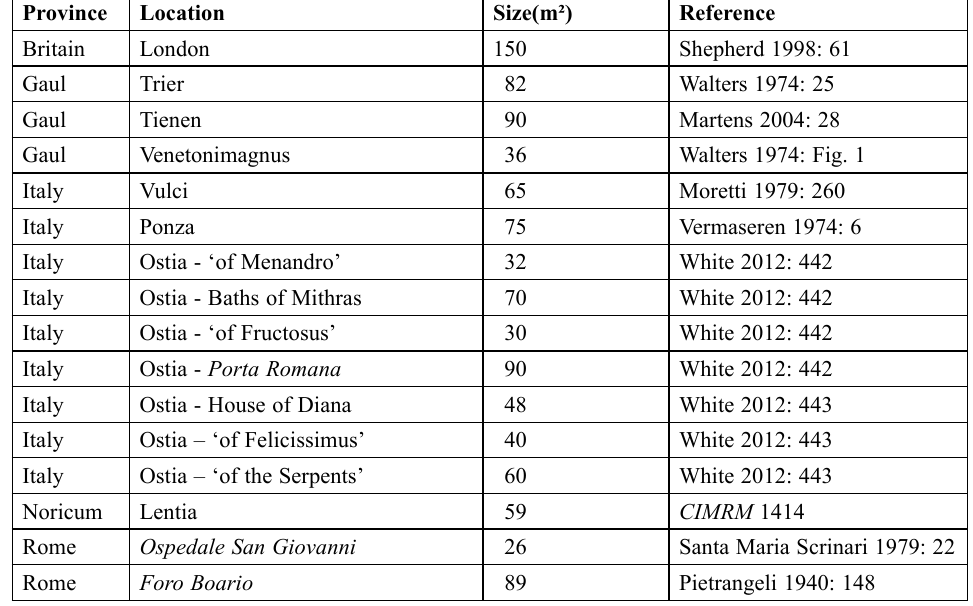
Table 1: The size of urban Mithraea constructed c . A.D.